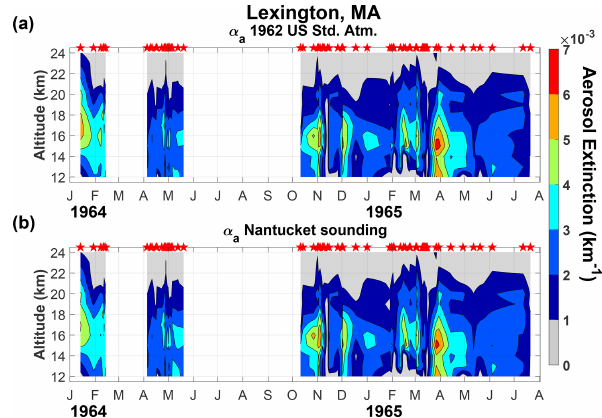
Figure 1. (a) Contour plot of the vertical profiles of 532nm aerosol extinction α a (532 ,z ) calculated using the same β m (694 ,z ) profile from the 1962 US Standard Atmosphere for all the days. (b) The contour plot of the vertical profiles of 532nm aerosol extinction α a (532 ,z ) was calculated using the daily β m (694 ,z ) profiles from the sounding at Nantucket, MA. The red stars indicate the dates the measurements were conducted. The measurement gaps longer than 1 month – March, and July to September both in 1964 – have been left